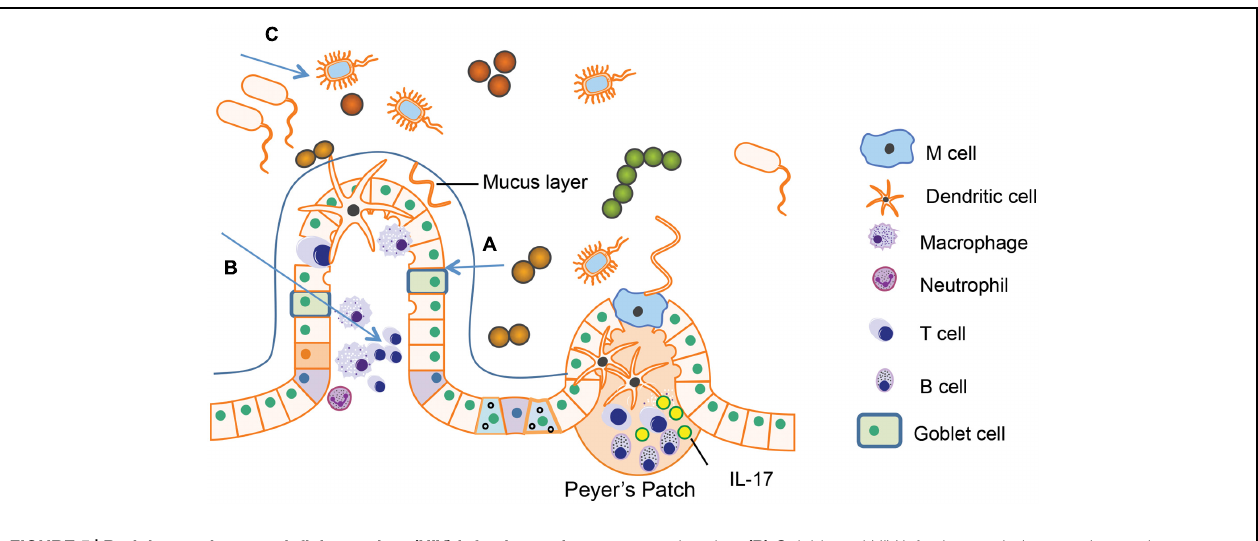
translocation. (B) Opioids and HIV infection can induce an abnormal inflammatory response in the gut. (C) Opioids and HIV infection has been shown to induce dysbiosis in the gut